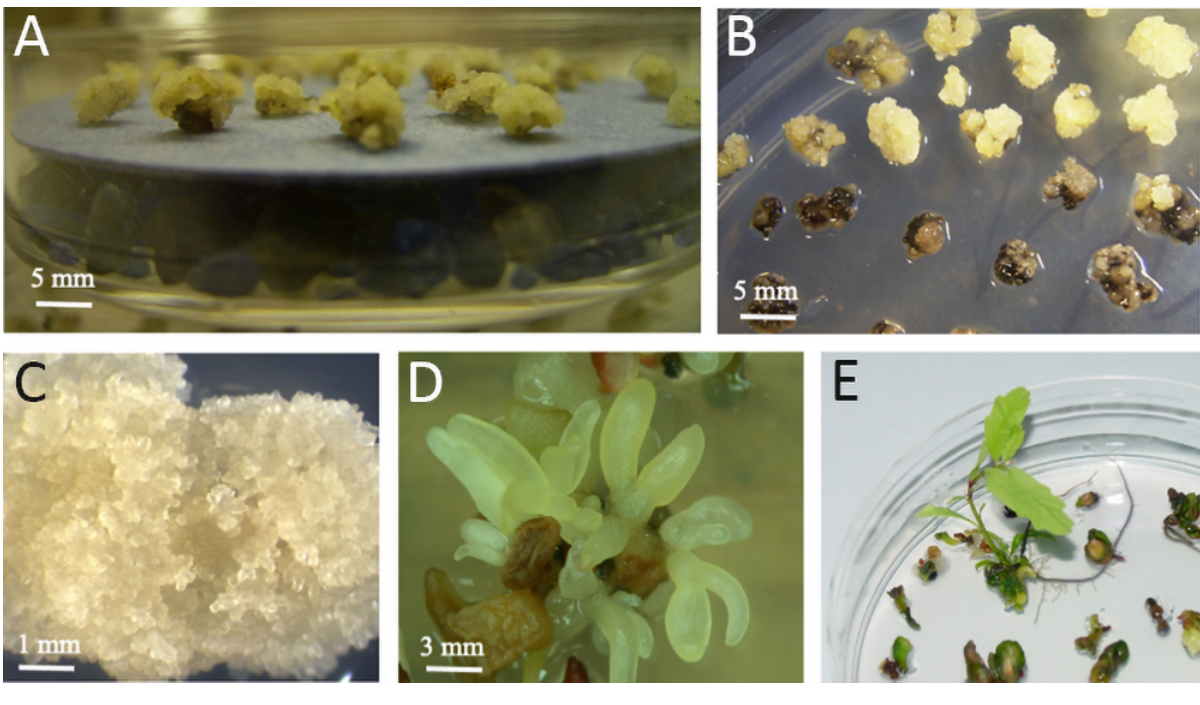
Figure 3 Clumps of Quercus robur embryogenic tissue: ( A ) desiccated over silica gel were added for 3 hr: ( B,C ) survived (yellow) and dead (black) aer cryopreservation; ( D ) mature somatic embryos with cotyledons; ( E ) somatic embryos germinated into plantlets with shoots, leaves, and roots (Chmielarz et al.,